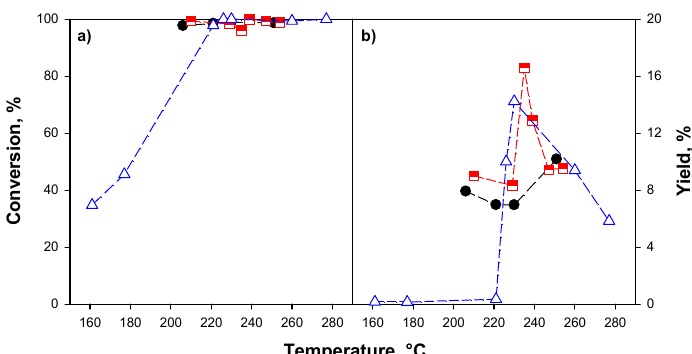
Figure 7. ( a ) Glycerol conversion, ( b ) yields to acrolein as a function of temperature at different contact times: 0.043 (full symbols), 0.057 (semi-filled symbols), 0.088 (open symbols) g·s·cm − 3 ; Gly/H 2 O/O 2 /N 2 = 2/41/6/51 vol. %.